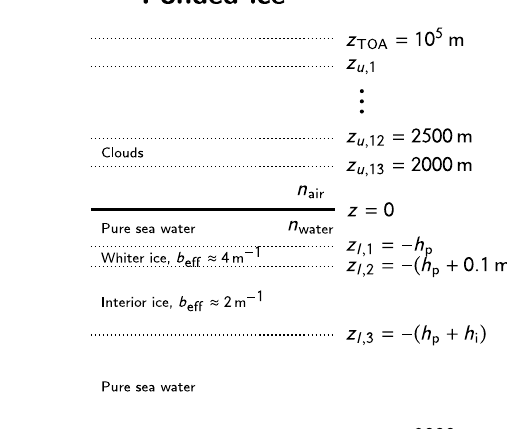
on the average pixel intensity of the aerial photo (see below), with higher air volume fractions for brighter areas.